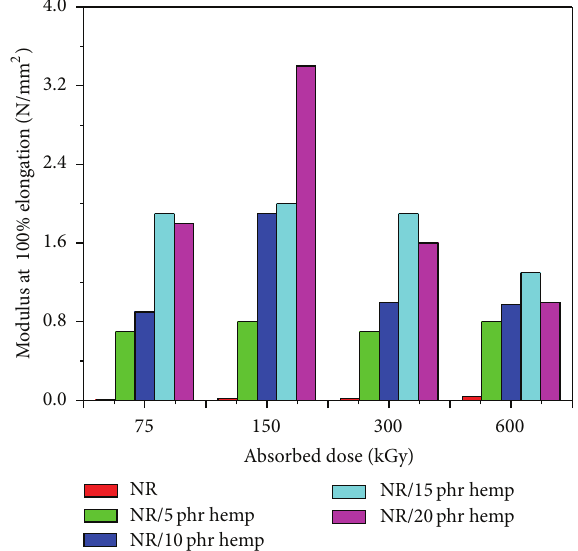
Figure 3: Modulus at 100% elongation variation as a function of hemp amount and irradiation